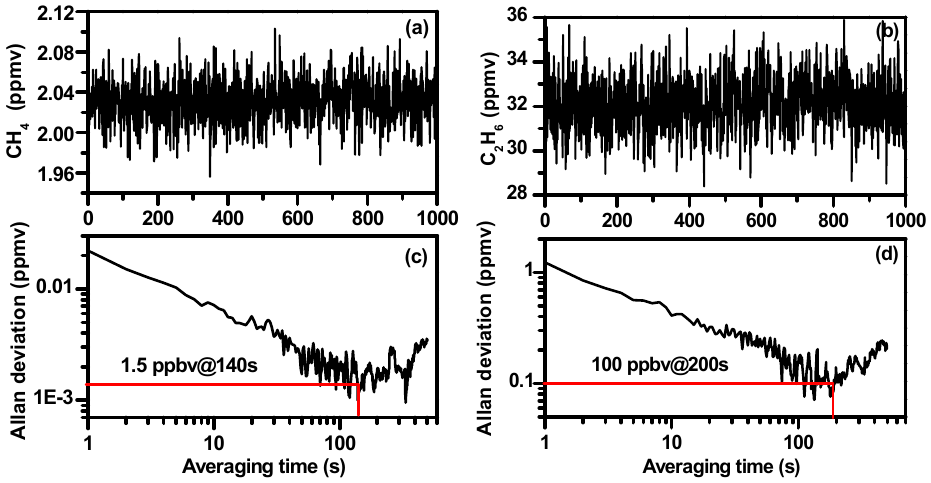
Figure 14. Time series measurements of CH 4 ( a ) and C 2 H 6 ( b ). Allan deviation plots for the CH 4 ( c ) and the C 2 H 6 ( d ) measurements.